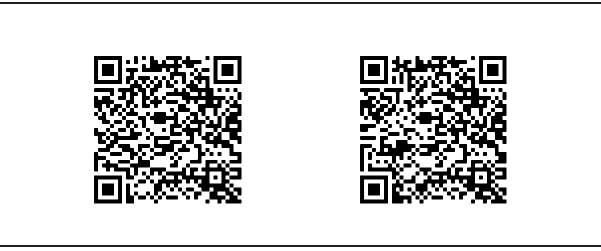
Video 1 - LV ventriculogram. After contrast injection, a septal-apical VSD is revealed. Estimated LVEF of 40%. Video 2 - 2D color echocardiogram. The apical 4-chamber view shows a non-restrictive VSD with left-to-right